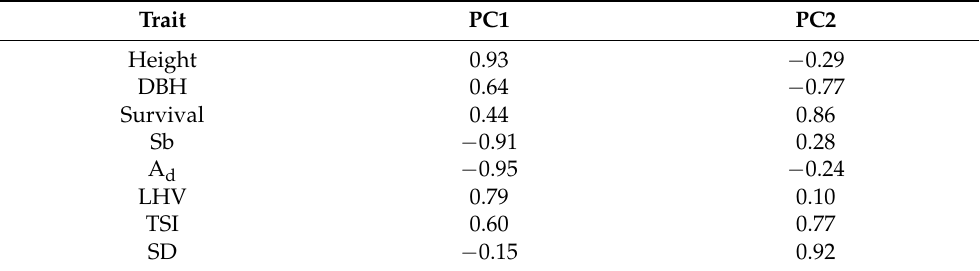
Table 6. Pearson correlation coefficients between traits and the principal components (PC1, PC2). Trait